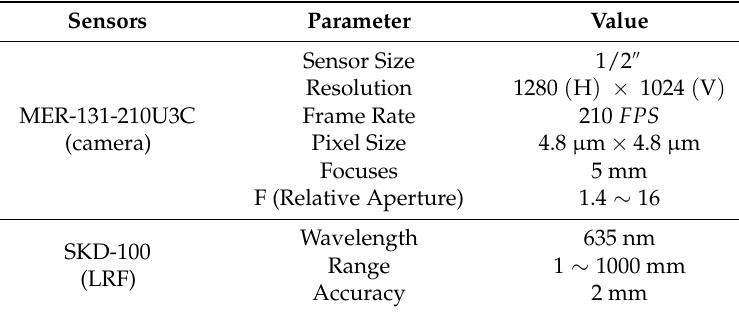
Table 3. The system parameters of 1D LRF and camera.